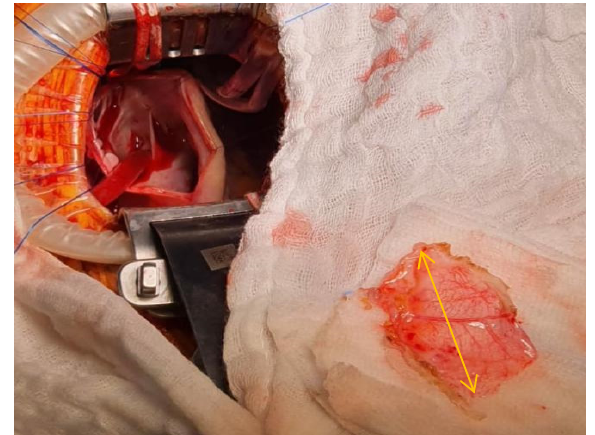
Figure 5. Pericardial patch sizing (pericardial patch—yellow arrow).